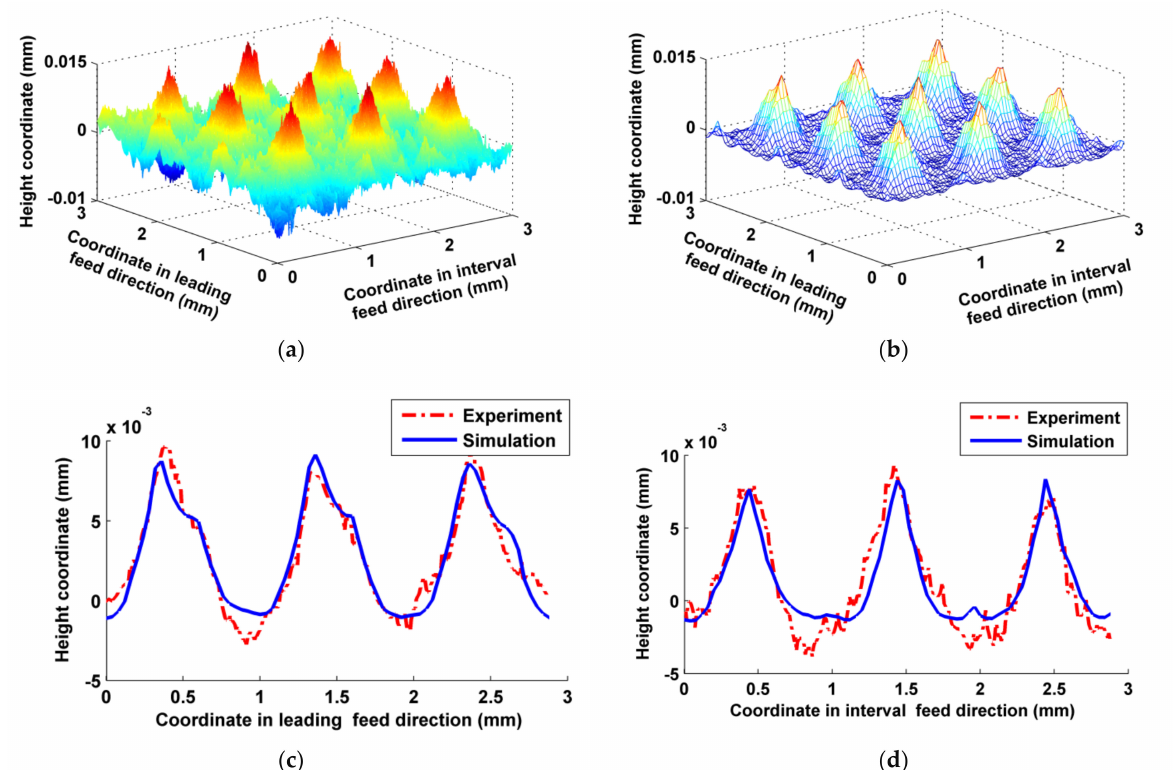
Figure 10. Comparisons between the simulated and experimental micro surface topography in inclining milling. ( a ) Actual milled surface topography; ( b ) Simulated surface topography; ( c ) Comparison of the sectional profiles in leading feed direction; ( d ) Comparison of the sectional profiles in interval feed direction.